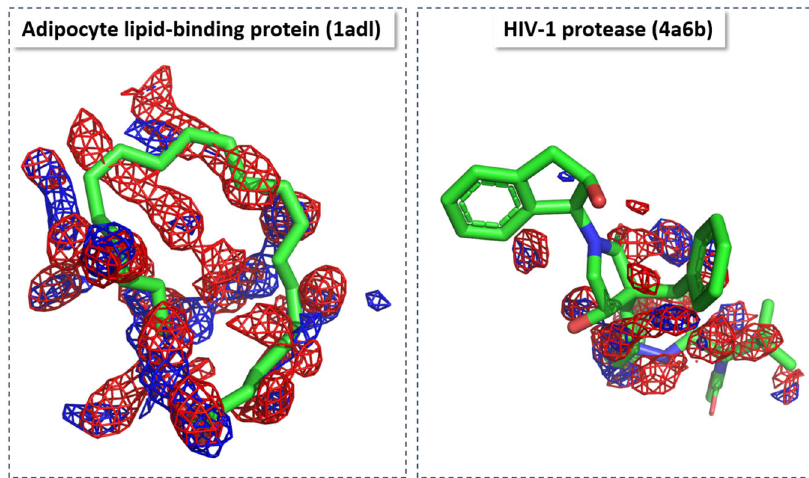
Fig. 5 Accuracy of U-Net method focused on binding site. Visual comparison between group truth (red) and neural-network predicted (blue) water occupancy for adipocyte lipid-binding protein (PDB-code: 1adl) and HIV-1 protease (4a6b) within 5 Å of the co-crystallized ligand. Note that the ligands were not included either in the water simulations to produce the ground truth or in the generation of input MIF grids. They were added for visualization purpose only. Predictions were performed using Inception + Residual U-net. Isosurfaces at a threshold value of 0.045 are shown.